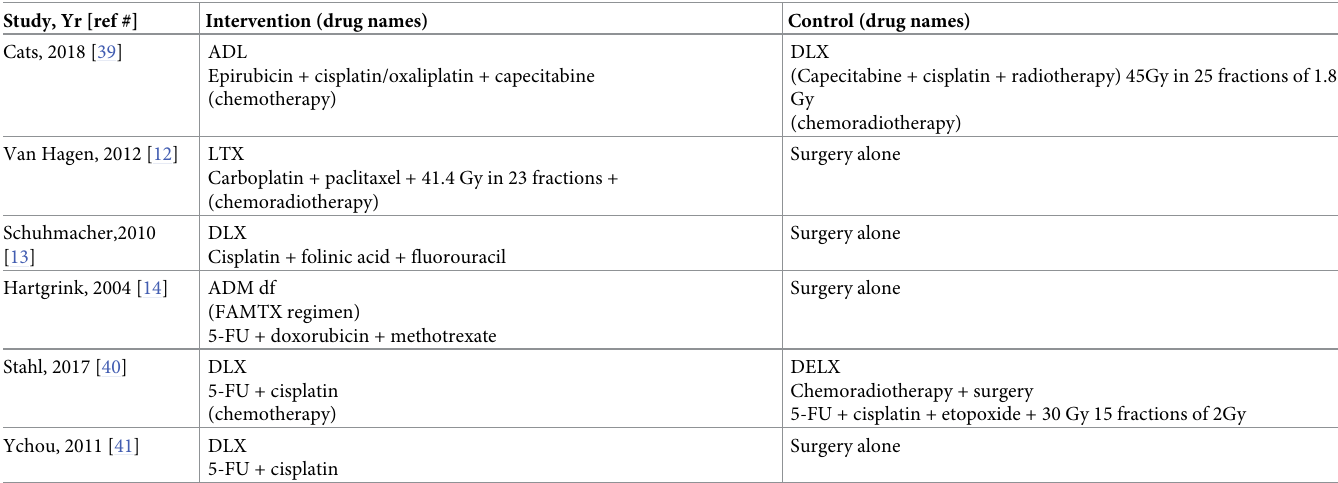
Table 3. Drug name of the drug class in the included